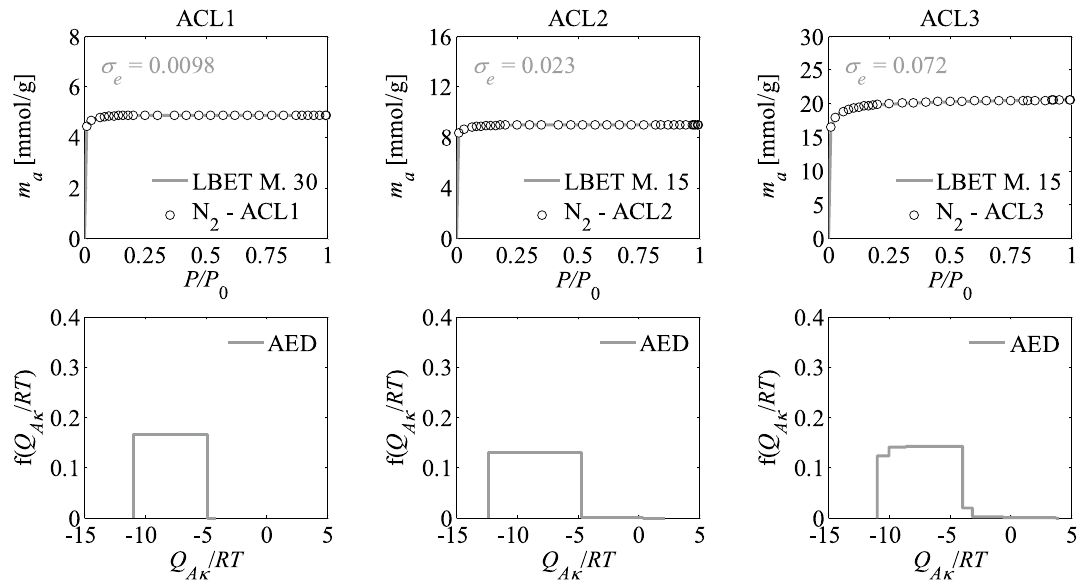
Figure 1. Nitrogen adsorption isotherms and adsorption energy distributions (AED) obtained by applying the LBET method to the experimental data for the activated carbons ACL R developed by chemical activation of Pine cones with KOH, at the lowest temperature i.e. T = 873 K with the different impregnations ratios ( R = 1, 2, 3); σ e is the dispersion of fitting